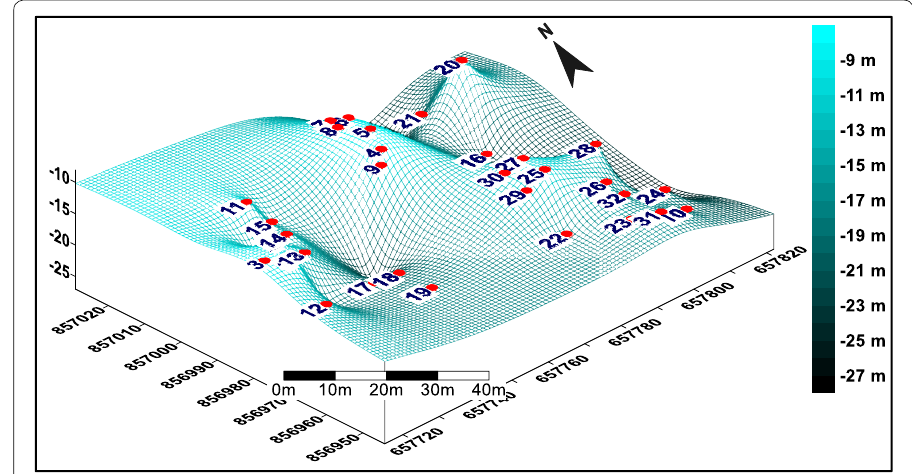
Fig. 14 3D wireframe layer of basement relief underlying the area